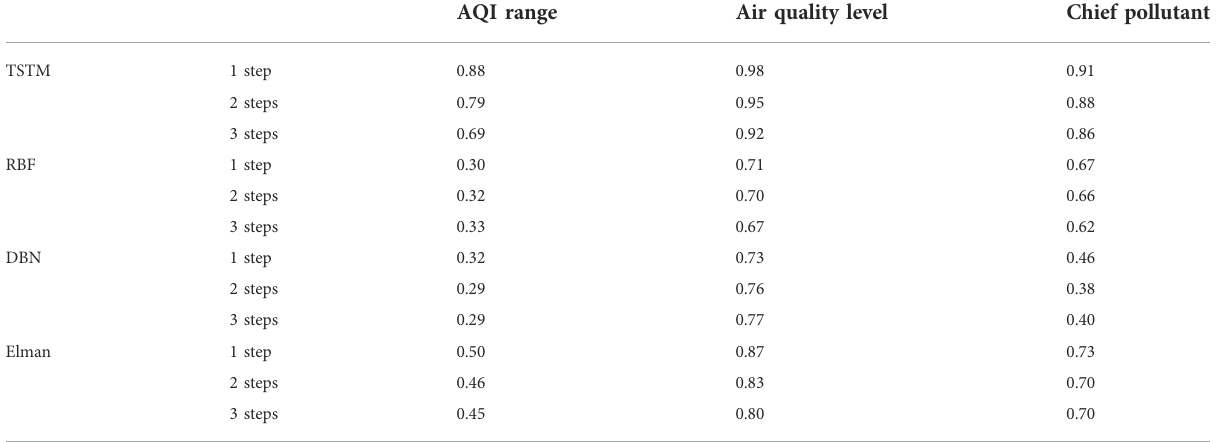
TABLE 1 Accuracy of four models for air quality forecast in Beijing.